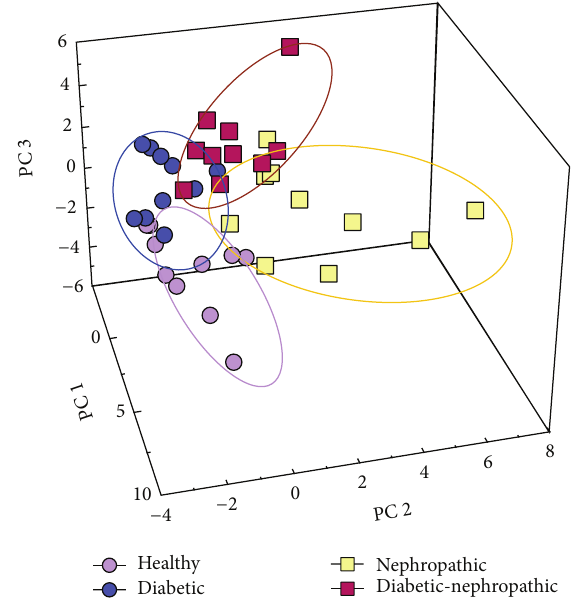
Figure 11: 3D plot of the first three components resulting from the principal component analysis (PCA) of the MALDI spectra of patients and controls, using data that were statistically different at ANOVA ( 𝑃 < 0.05 ). The ovals indicate the regions of the principal component space containing data related to the different pop- ulations (healthy subjects as well as diabetic, nephropathic, and diabetic-nephropathic patients). From [42], by kind permission of Wiley and Sons through RightsLink, License no.